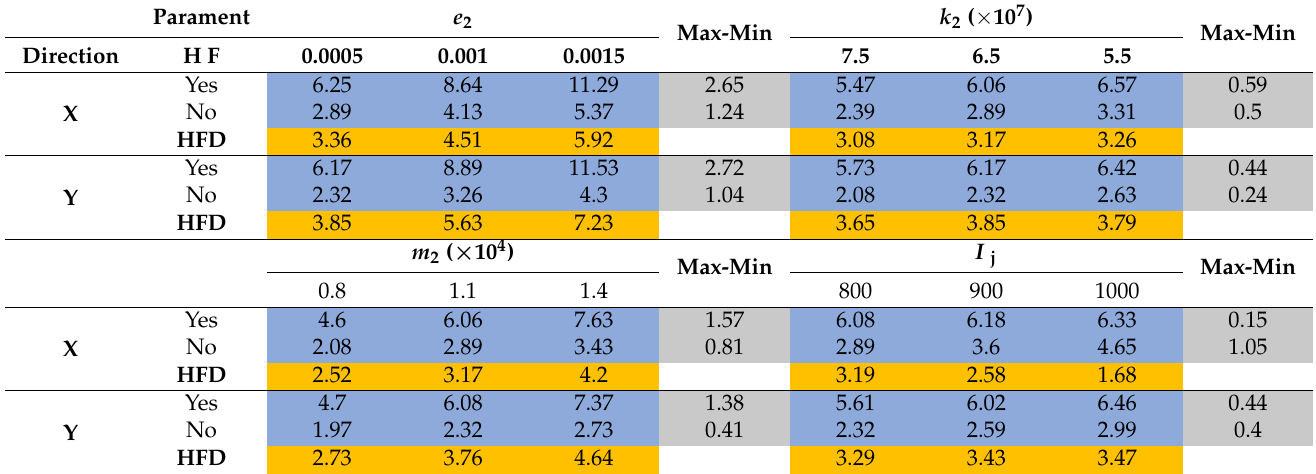
Table 2. Comparison between the vibrations of HGS with or without hydraulic vibration